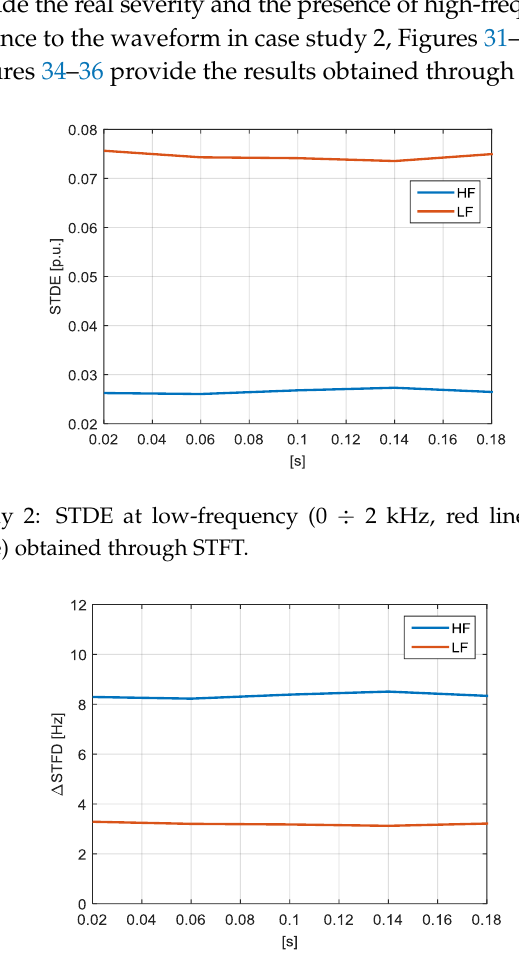
Figure 30. Case study 1: Δ STK at low-frequency (0 ÷ 2 kHz, red line) and at high-frequency (2 ÷ 150 kHz, blue line) obtained through Prony’s method.